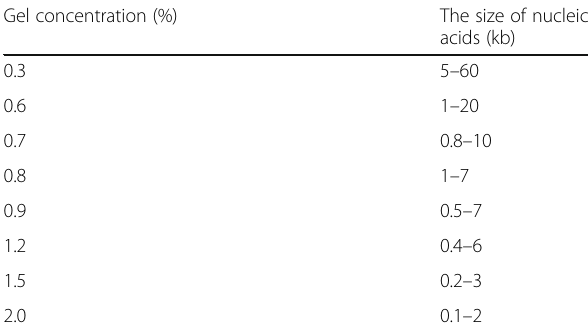
Table 2 Recommended agarose gel concentrations based on fragment length from nucleic acid samples Gel concentration (%) The size of nucleic